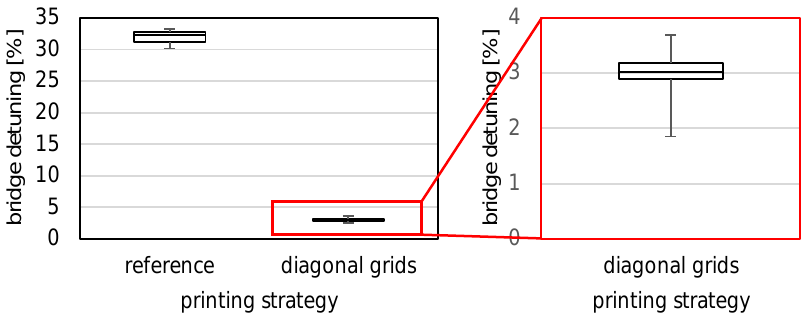
Figure 13. Detuning of SG full bridges.